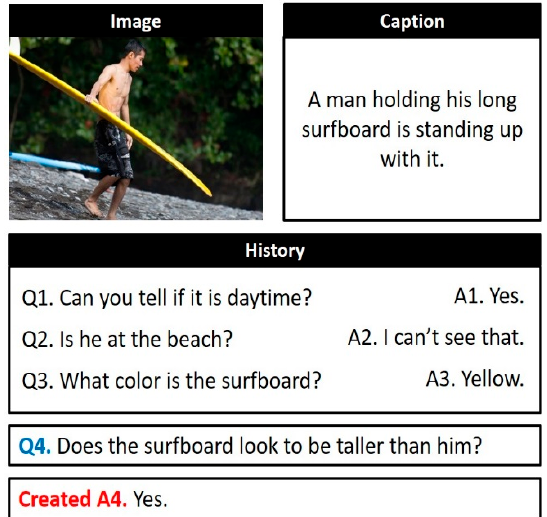
Figure 1. Example of a visual dialog.